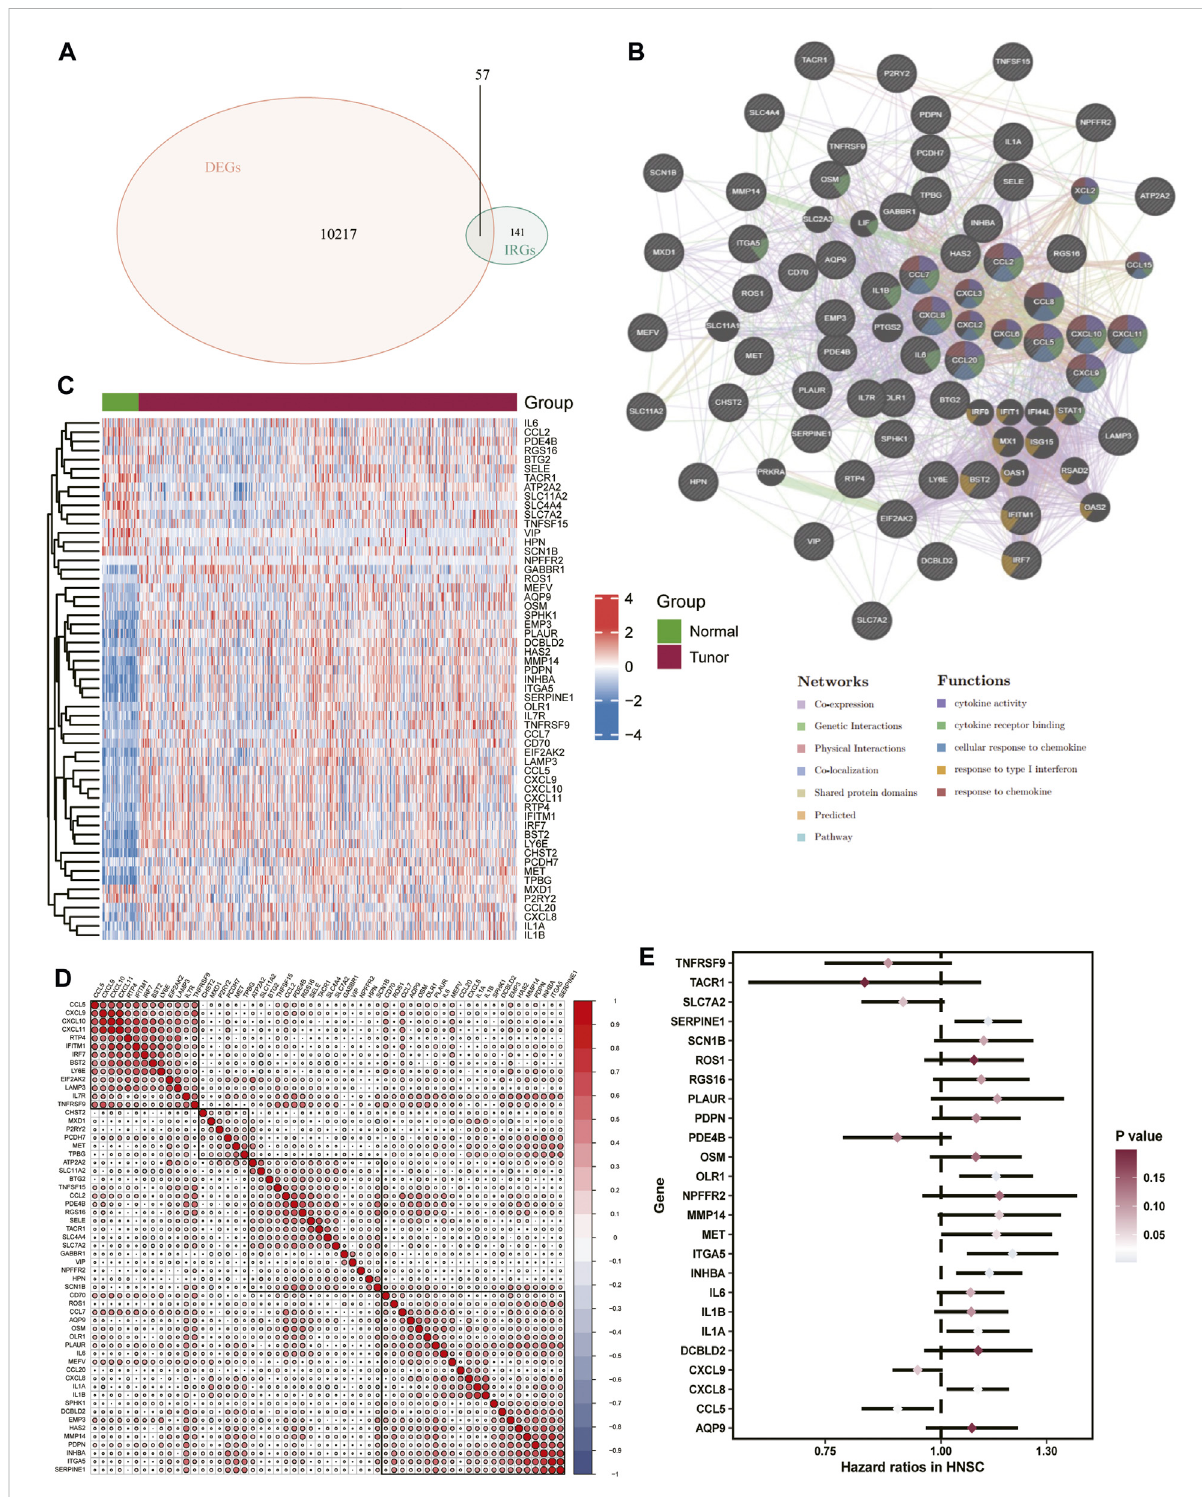
FIGURE 2 Extraction of correlated DEGs. (A) Venn diagram of in fl ammatory response-related genes versus differentially expressed genes in TCGA-HNSC. (B) Interactionnetwork mapof57differentiallyexpressedgenes, (C) Heatmapofdifferentiallyexpressedgenes (D) Heatmapofcorrelationbetween differentially expressed genes. (E) Forest plot of the prognostic value of in fl ammation-associated genes